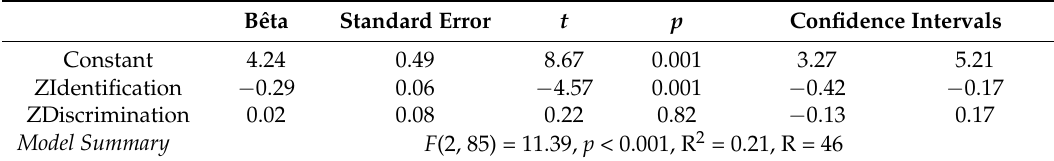
Table 3. Direct effect of identification on perceived